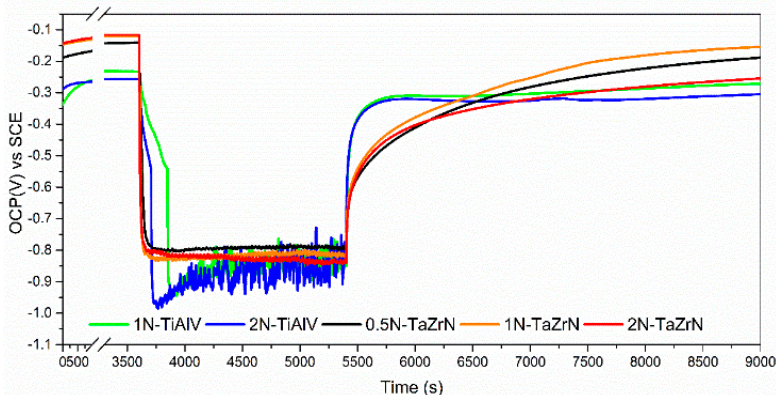
Figure 12. Evolution of OCP measured during the tribocorrosion tests.